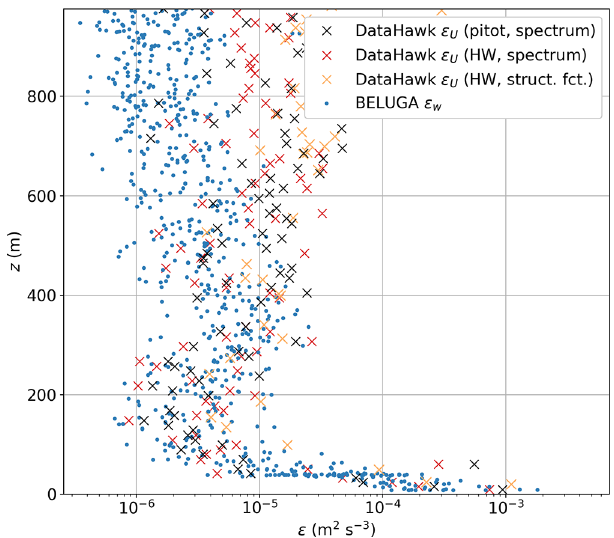
Figure 3. Comparison of different methods for calculating ε (sub- scripts indicate the wind component that ε was derived from): ver- tical profile (ascent) for 26 July 2020. For DH2, ε is derived using the spectral method from pitot and hot-wire measurements and ap- plying the second-order structure function method to hot-wire mea- surements for comparison with BELUGA. ε for BELUGA is de- rived using the second-order structure function for the vertical wind velocity component w